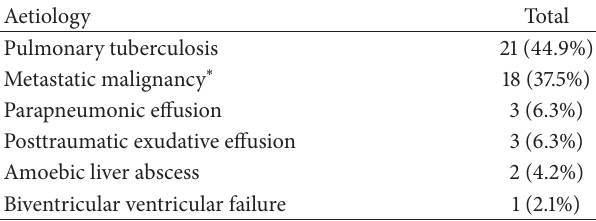
Table 1: The aetiology of massive pleural fluid collections.